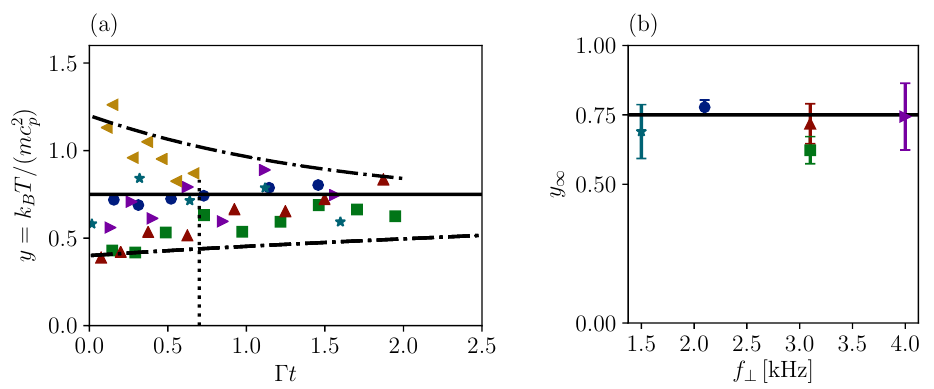
) for the different data sets, T / ( mc 2 B p = 0.75. The dashed- ∞